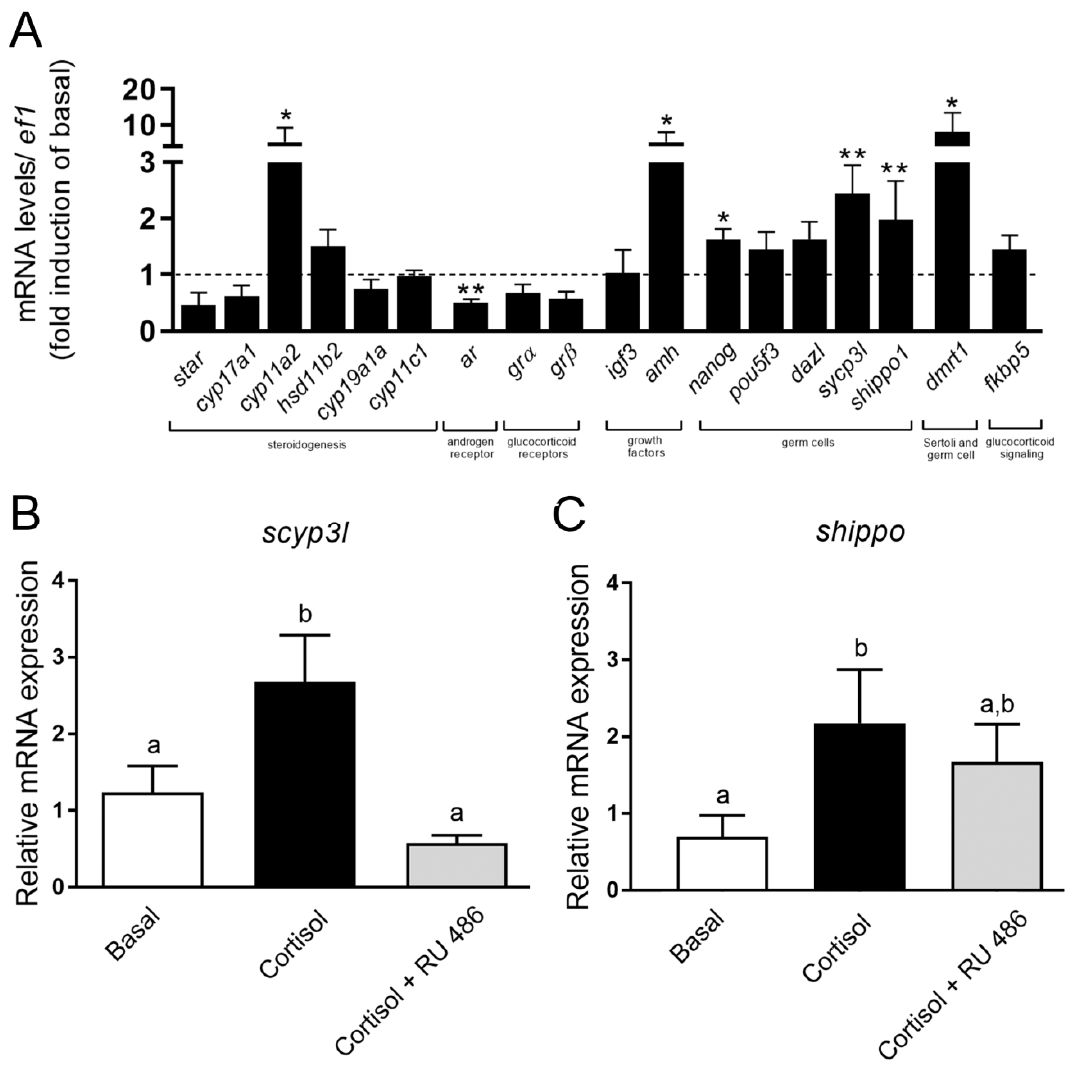
Figure 5. ( A ) Relative mRNA levels of several selected genes in zebrafish testes incubated for 7 days (long-term exposure) in the presence or absence of 100 ng / mL cortisol. The relative mRNA levels of star (steroidogenic acute regulatory), cyp17a1 (17 α -hydroxylase / 17,20 lyase / 17,20 desmolase), cyp11a2 (cytochrome P450, family 11, subfamily A, polypeptide 2), hsd11b2 (11-beta hydroxysteroid dehydrogenase), cyp19a1a (cytochrome P450, family 19, subfamily A, polypeptide 1a), cyp11c1 (cytochrome P450, family 11, subfamily C, polypeptide 1), ar (androgen receptor), gr α (glucocorticoid receptor apha), gr β (glucocorticoid receptor beta), igf3 (insulin-like growth factor 3), amh (anti-Müllerian hormone), nanog (nanog homeobox), pou5f3 (POU domain, class 5, transcription factor 3), dazl (deleted in azoospermia-like), sycp3l (synaptonemal complex protein 3), shippo (outer dense fiber of sperm tails 3B), dmrt1 (doublesex and mab-3 related transcription factor 1), and fkbp5 (FKBP prolyl isomerase 5) were normalized with the ef1 (elongation factor 1 α ) levels. Bars represent the mean ± SEM fold change ( n = 8), relative to the control (basal, 0 ng / mL), which is set at 1 (line). Paired t -test, ** p < 0.01; * p < 0.05. ( B , C ) Relative mRNA expression of sycp3l and shippo in the zebrafish testes incubated for 7 days with either basal (L-15), cortisol (100 ng / mL), or cortisol (100 ng / mL) + RU 486 (1 µ g / mL). Expression levels of sycp3l and shippo were normalized with ef1 . Bars represent the mean ± SEM ( n = 8 per treatment). ANOVA followed by Student–Newman–Keuls; di ff erent letters indicate significant di ff erences ( p < 0.05) between treatment